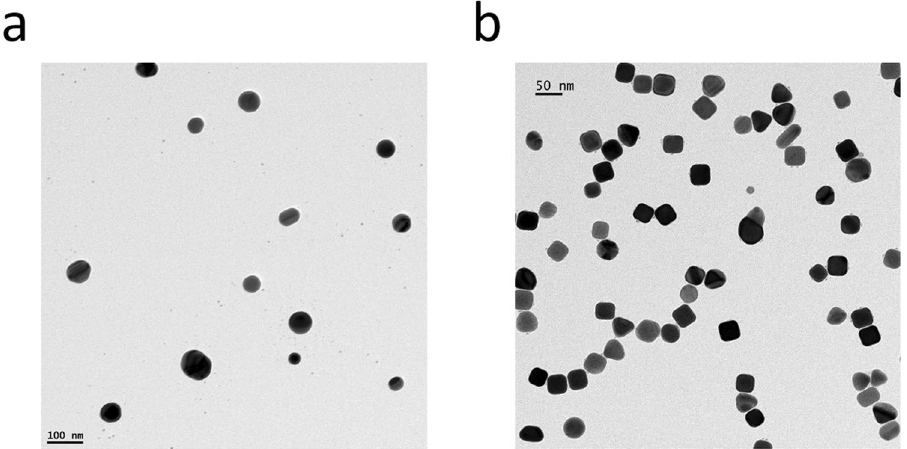
Figure 1. TEM images silver nanoparticles ( a ) AgNS and ( b ) AgNC.